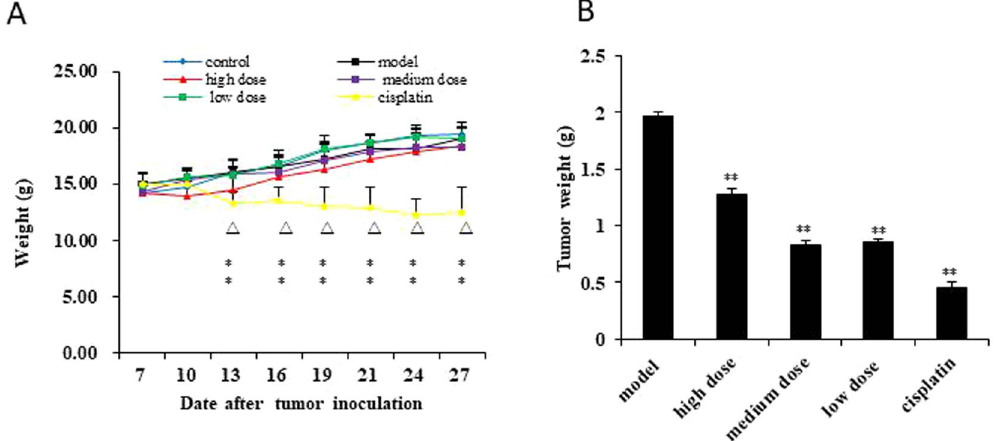
Figure 1. GLE effectively inhibited tumor growth in vivo . ( A ) The weight of mice was significantly reduced in cisplatin group from the 10th day ( P < 0.01) compared with those in model group and control group. The difference was no statistically significant in GLE treatment group. ( B ) The average tumor weight in GLE treatment and cisplatin groups decreased significantly compared with those in model group ( P < 0.01). Representative results of three independent experiments are shown. Error bars, SD; * P < 0.05; ** P < 0.01, versus control values; Δ P < 0.05; ΔΔ P < 0.01, versus model